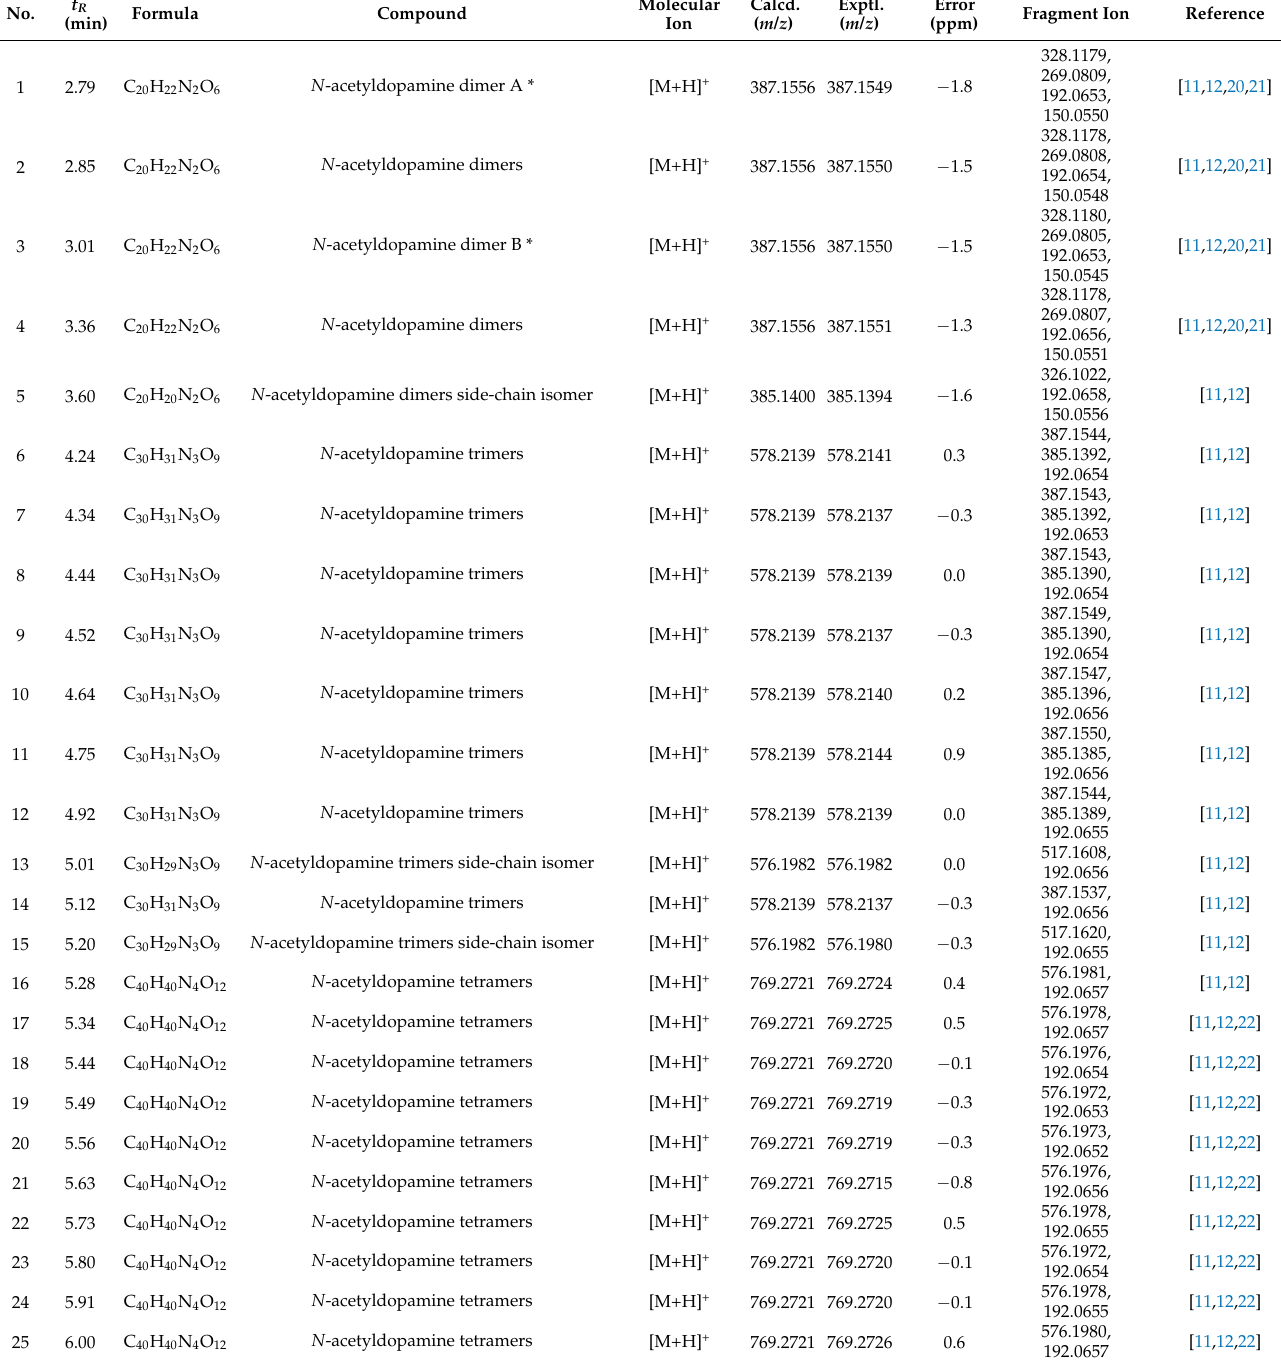
Table 1. Structural information of N -acetyldopamine oligomers identified in CP